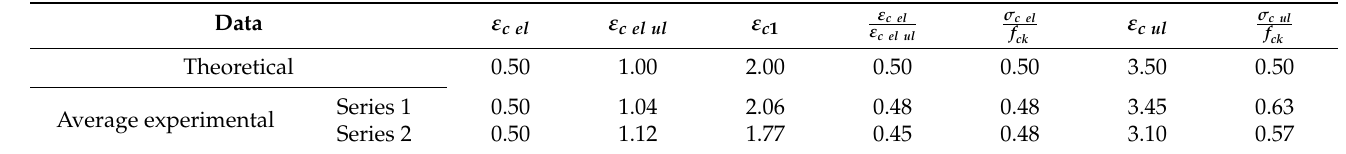
diagram parameters.